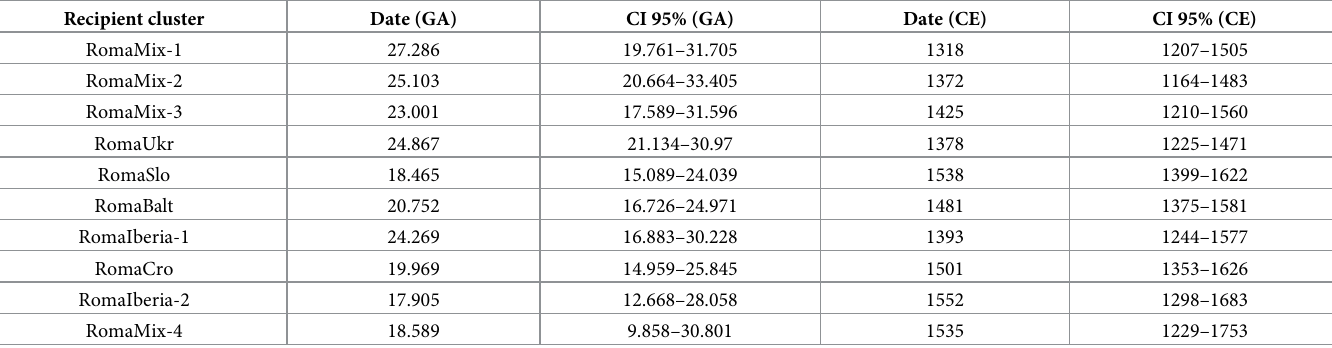
Table 1. Admixture dates inferred by GLOBETROTTER for each European Roma cluster with each estimated date and 95%CI from 100 bootstrap resamples in generations ago (GA) and years CE (considering a generation time of 25 years). The first historical records of Roma presence in each sampled European country [1,60,61]are shown with the same assumptions as in